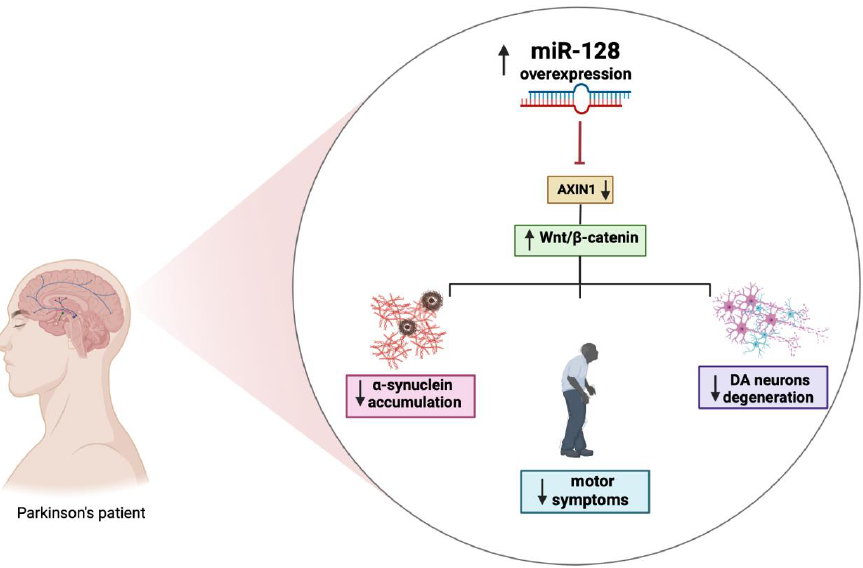
Figure 2. The role of miR-128 in PD. Figure created with BioRender.com accessed on 1 March 2023.